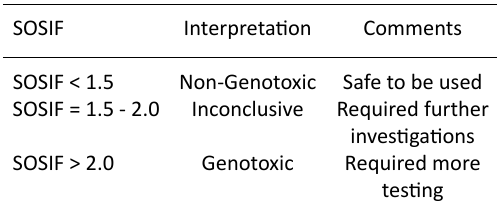
Table 2. The SOSIF Classification SOSIF SOSIF ˂ 1.5 SOSIF = 1.5 - 2.0